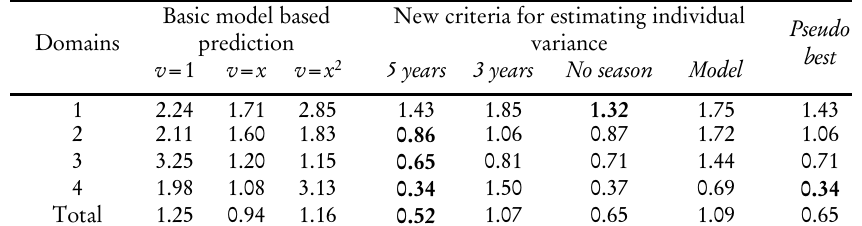
Comparison among MAPEs obtained through the use of the optimal model based predictor and different criteria for model unit variance